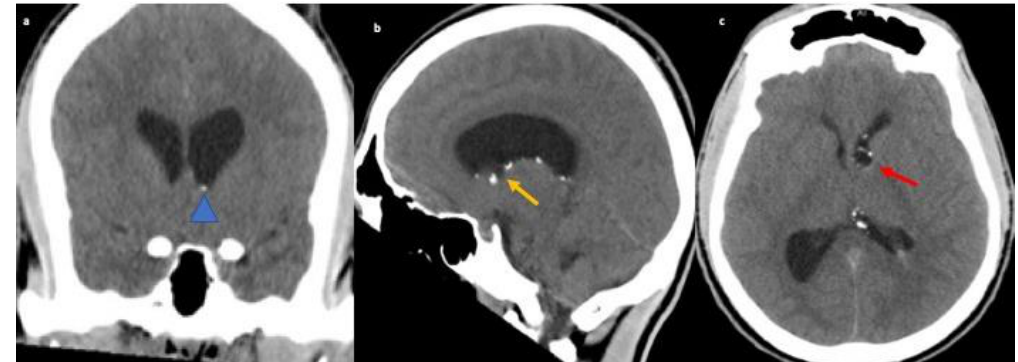
Figure 3. CT Head non-contrast coronal ( a ) reveals small punctuate foci of calcification along the left lateral ventricle (blue arrow head). Additional CT head sagittal and axial ( b , c ) reveals 9 mm × 6 mm fluid density lesion in the frontal horn of left lateral ventricle with peripheral calcification near foramen of Monro (yellow and red arrow) leading to obstructive supratentorial hydrocephalus. Additional small punctuate foci of calcification along the left lateral ventricle.